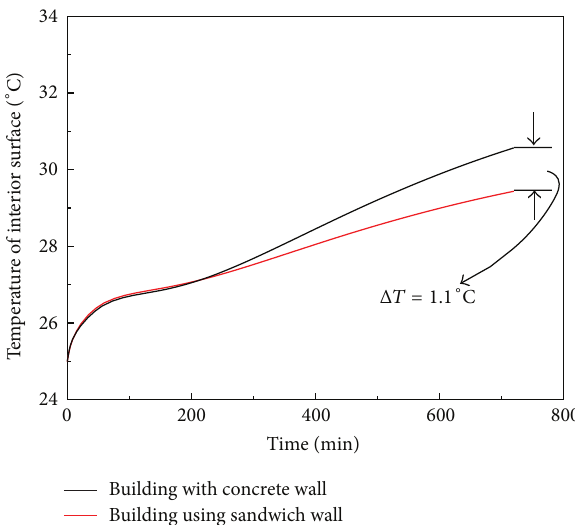
Figure 8: The temperature variations of the interior surfaces in two three-story building models with different wall panel